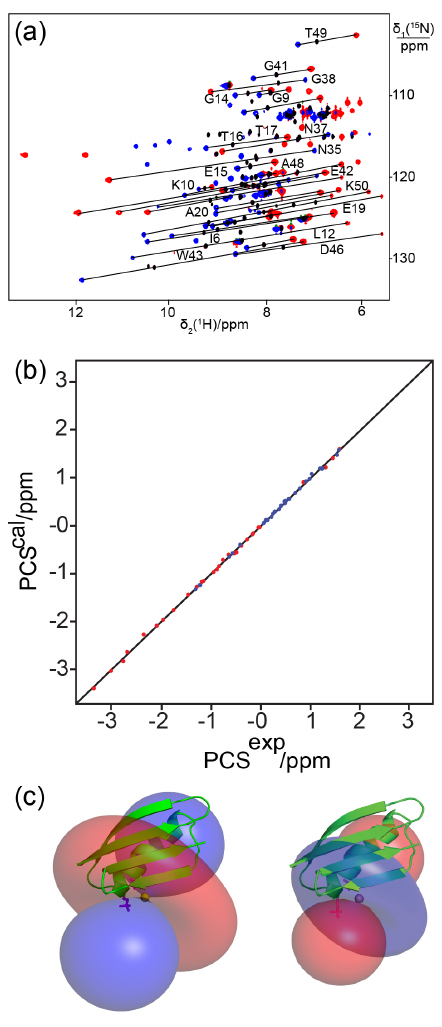
Figure 4. The double-phosphoserine mutant GB1 A24Sep/K28Sep generates high-quality PCSs. (a) Superimposition of [ 15 N, 1 H]- HSQC spectra of 0.3mM solutions of GB1 A24Sep/K28Sep in the presence of Tb 3 + (red cross-peaks), Tm 3 + (blue cross-peaks), or Y 3 + (black cross-peaks). Lines were drawn to connect selected cor- responding cross-peaks observed with diamagnetic and paramag- netic metal ions. (b) Correlation between back-calculated and ex- perimental PCSs. (c) Blue and red isosurfaces indicating PCSs of ± 1ppm, respectively, as determined by the (cid:49)χ tensors of Tb 3 + (left) and Tm 3 + (right). The side chains of Sep residues modelled at positions 24 and 28 are highlighted by a stick representation.